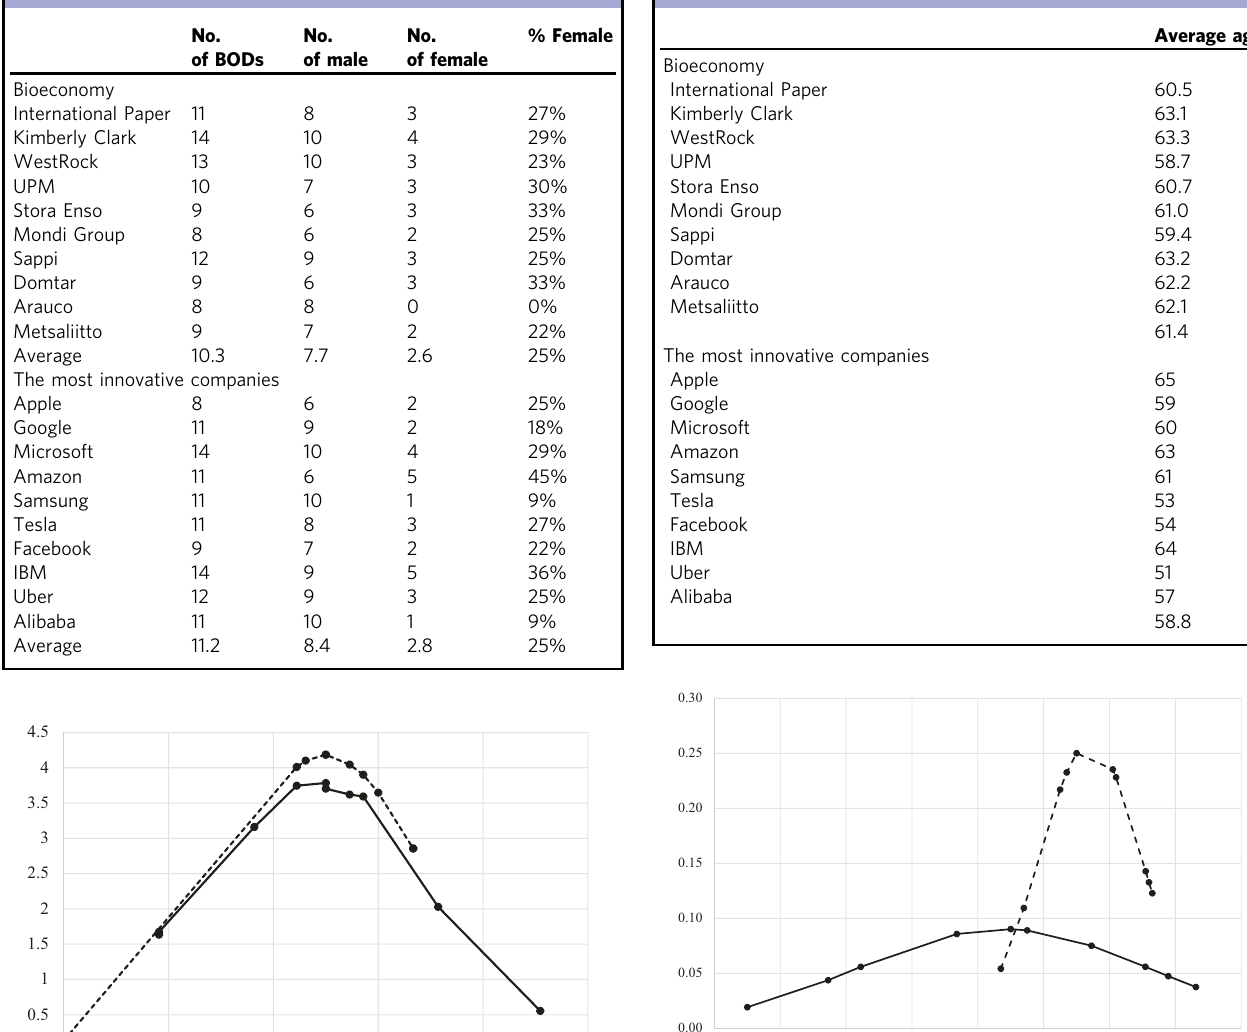
Table 4 Gender diversity in the bioeconomy and the most innovative companies.